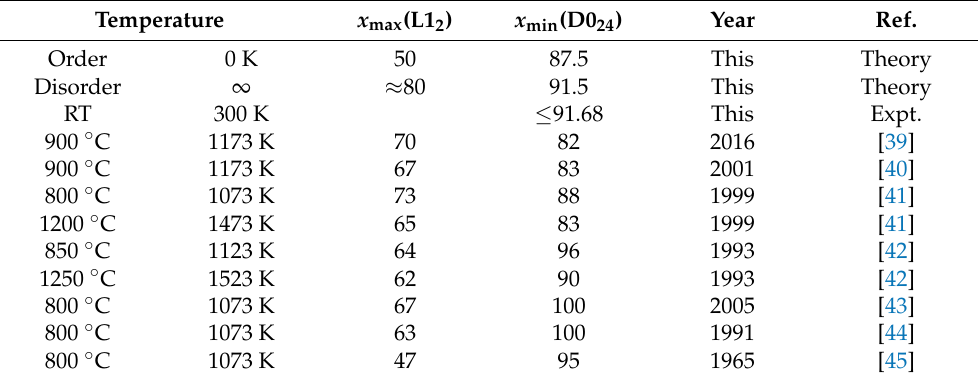
Table 1. Phase boundaries of L1 2 and D0 24 phases in Ni 3 (Al 1 − x Ti x ) 1 from our theory, our experiment, and literature. Here x (at.%Ti) is titanium atomic percent on the Al/Ti sublattice. Temperature x max (L1 2 ) x min (D0 24 ) Year Ref. Order 0